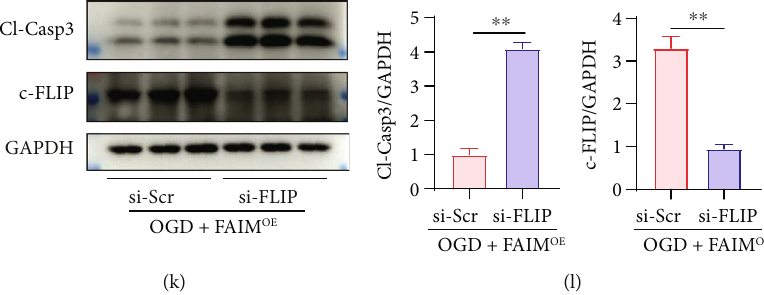
Figure 4: c-FLIP is required for the antiapoptotic e ff ect of FAIM. MSCs and MSCs were transfected with si-FAIM and exposed to Vec FLIP OGD. (a – b) Annexin V-APC/PI staining was performed, and fl ow cytometry was used to determine the apoptosis rate. (c – d) TUNEL staining of MSCs and MSCs after FAIM knockdown followed by OGD treatment for 12h. (e – f) Cleaved caspase 3 protein Vec FLIP transfected with si-FLIP or si-Scr under expression was detected by Western blotting. (g – h) Annexin V-APC/PI staining of MSCs FAIM after FLIP knockdown or control treatment followed by OGD treatment for 12h. OGD conditions. (i – j) TUNEL staining of MSCs FAIM (k – l) Cleaved caspase 3 protein expression was measured by Western blotting. The data are shown as the mean ± SD . Ns indicates not signi fi cant; ∗∗ denotes P < 0 : 01